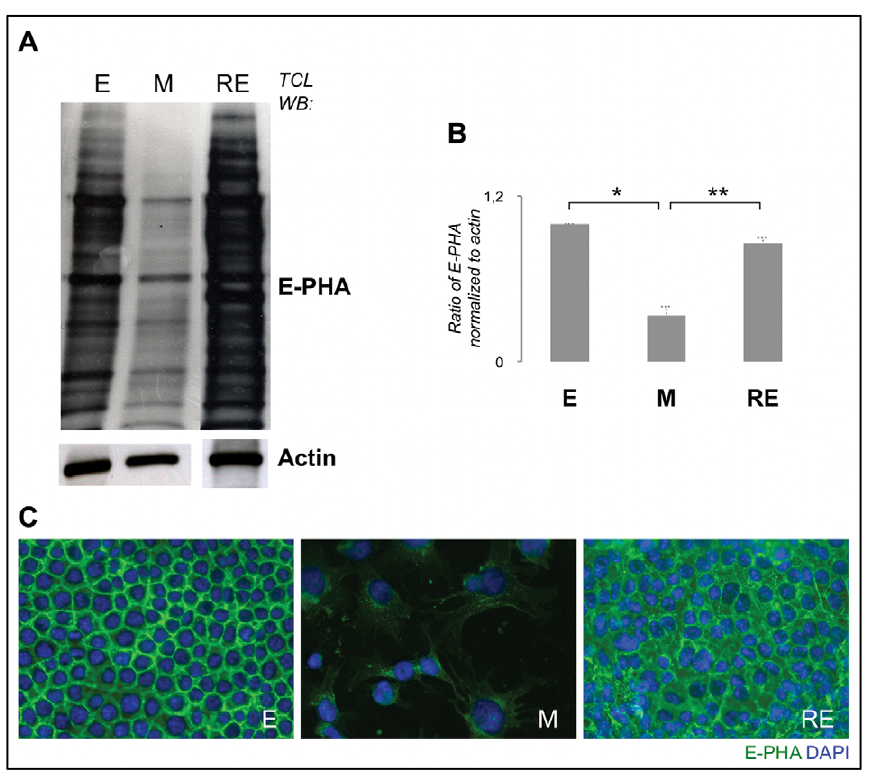
Figure 4. Expression levels and cellular localization of the product of GnT-III enzyme during EMT/MET induction. Panel A shows the lectin blot analysis using E-PHA lectin, showing the total expression levels of bisecting GlcNAc structures during EMT/MET. Panel B illustrates the quantification of E-PHA lectin normalized to actin ( n =2 biological replicas). Single asterisk corresponds to p # 0.05 and double asterisks stands for p # 0.001. Bisecting GlcNAc structures significantly decrease when comparing E and M cells and their expression is significantly recovered in RE cells. Panel C represents the immunofluorescence for E-PHA lectin during EMT/MET induction (400 6 ). Bisecting GlcNAc structures are preferentially localized in the cell membrane of E cells. M cells exhibit a clear decrease in expression of the bisecting GlcNAc structures that was only observed in focal areas in the perinuclear region. In RE cells, there was a significant increase in the E-PHA staining showing an increase in the expression levels of bisecting GlcNAc structures that are localized in the cell membrane and in the cytoplasm.